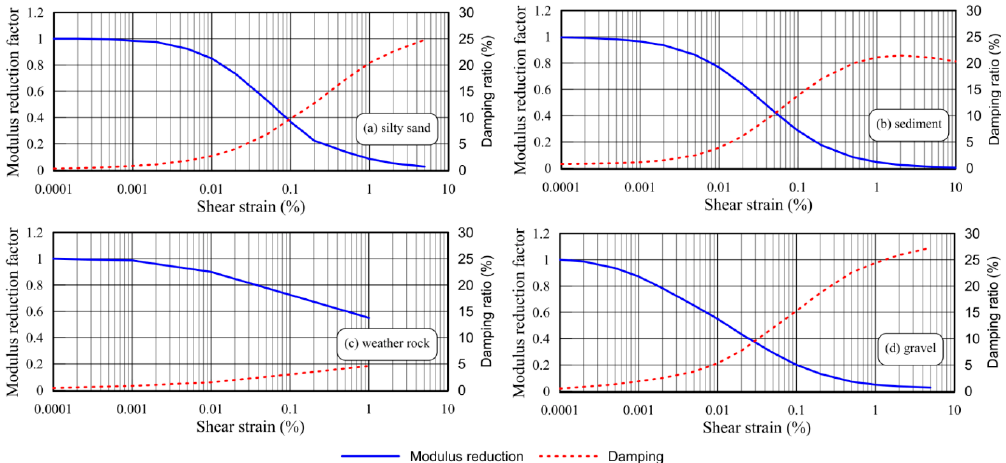
Figure 16. Modulus reduction and damping ratio curves for ( a ) silty sand, ( b ) sediment, ( c ) weather rock, and ( d ) gravel obtained from PROSHAKE analysis.